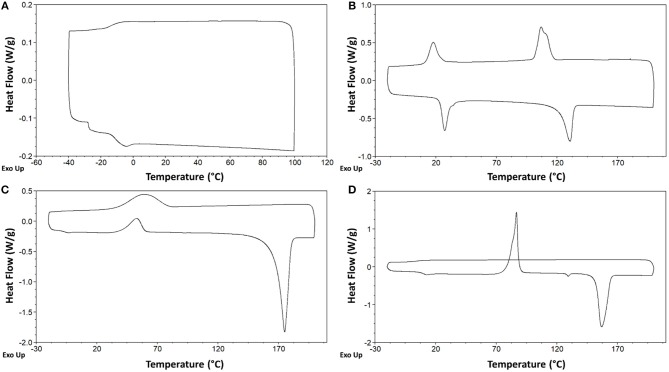
Differential scanning calorimetry (DSC) of compounds 7 [C5(BIM)2/2Br] (A), 9 [C3(HIM)2/2Br] (B), 8 [C6(BIM)2/2Br] (C), and 2 [C4(MIM)2/2Br] (D).